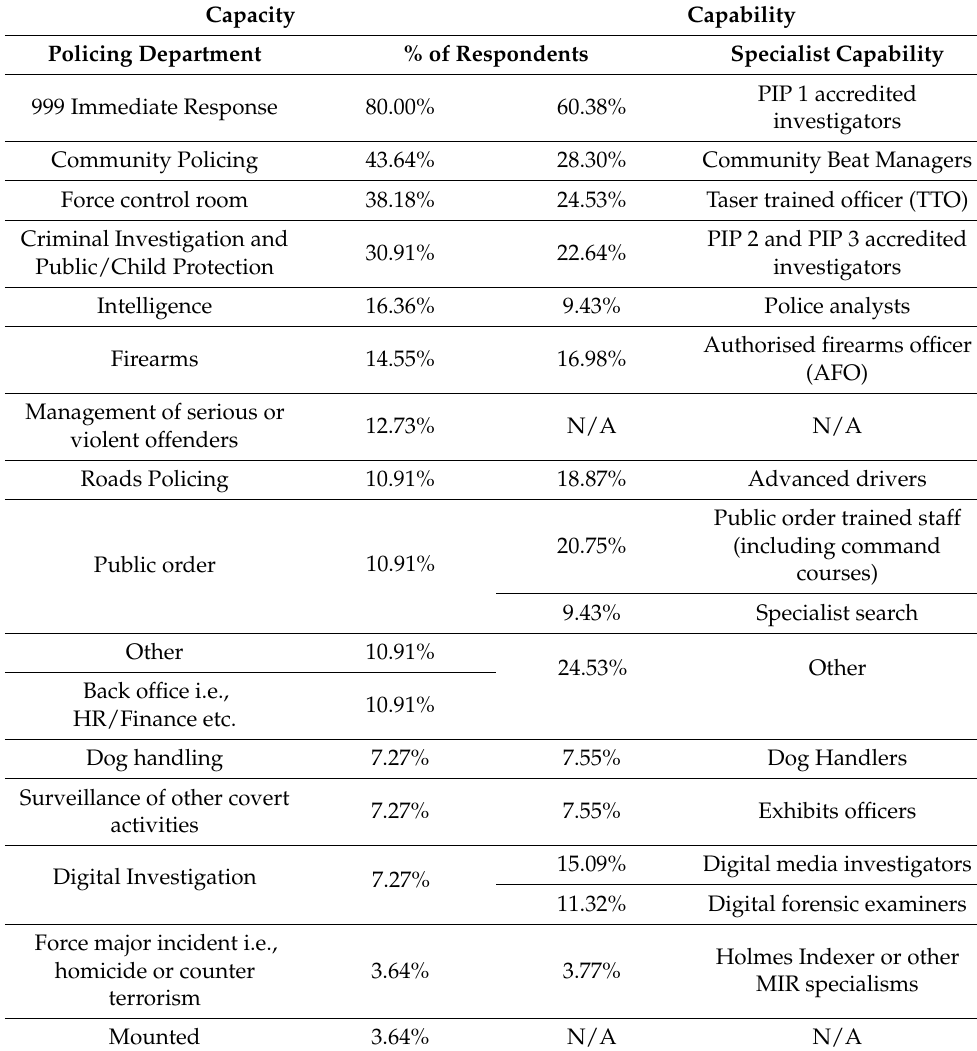
Table 4. Volume of survey respondents who believe access to available capacity or capability was significantly reduced due to